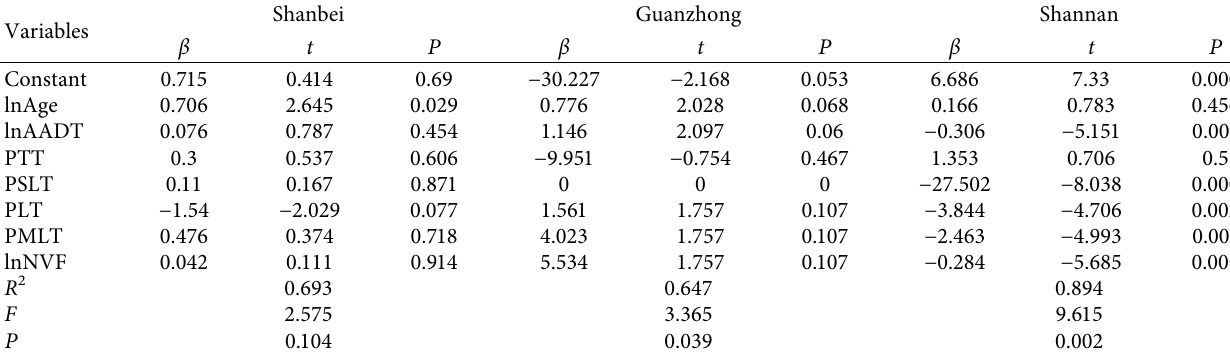
Table 5: Grouped ridge regression.